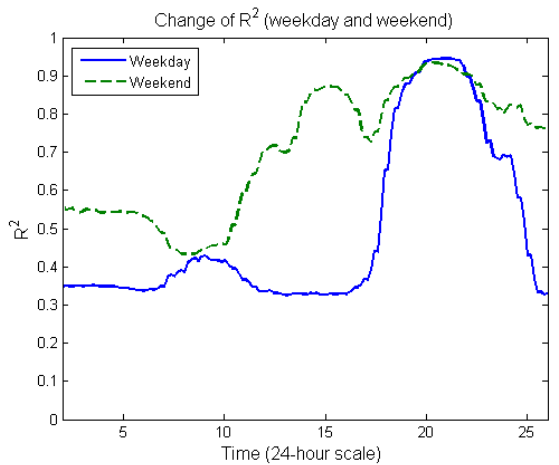
Figure 9. Daily fluctuation of Coefficients of Determination on weekdays and weekends.